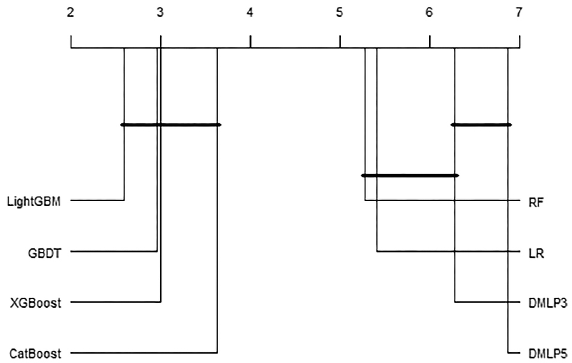
Figure 2. Critical difference plot of competing models over the average rank of all evaluation measures (sig- nificance level = 0.05). The models within the bold lines exhibit no significant difference in average